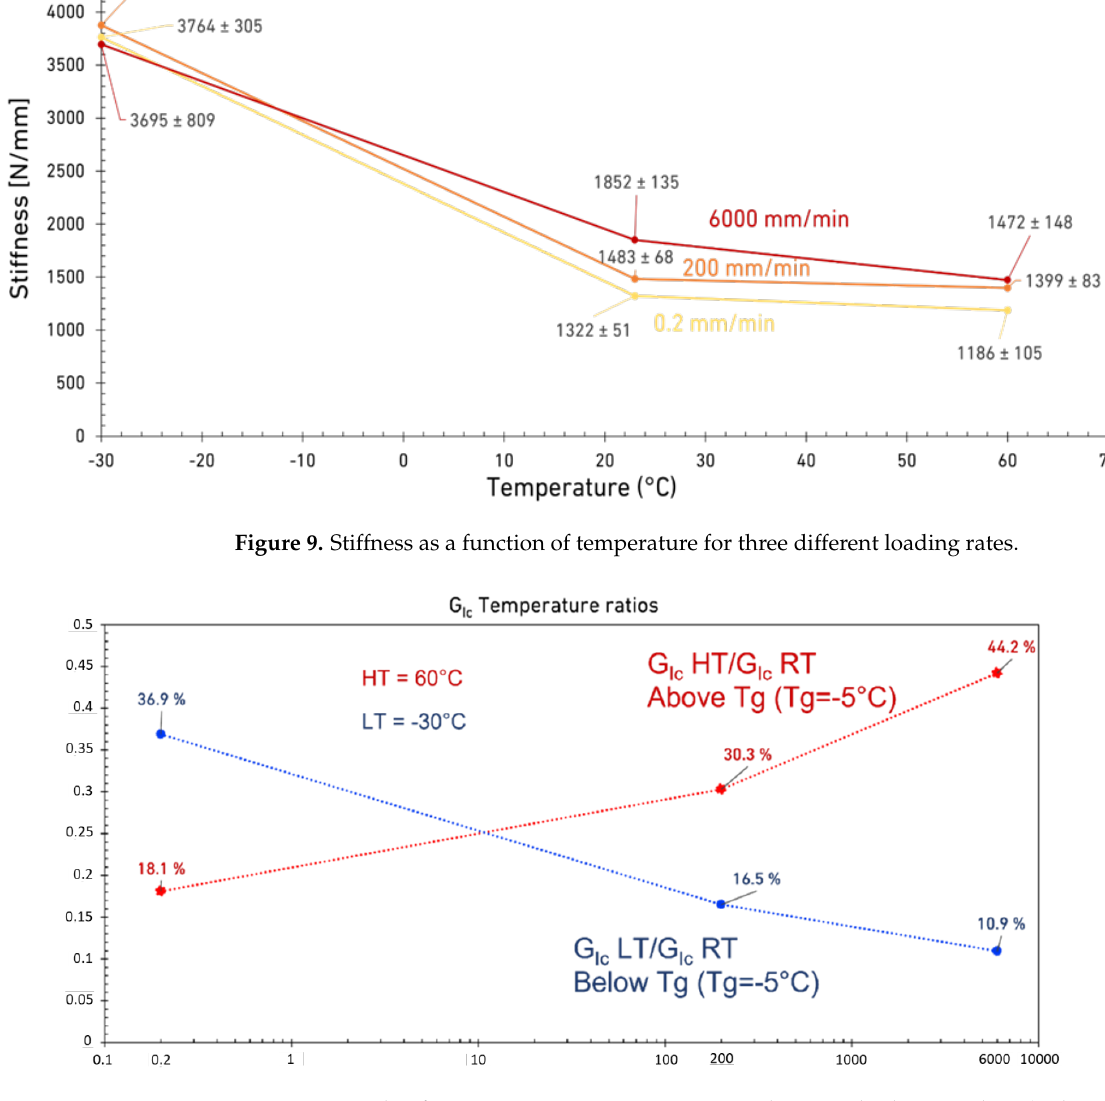
Figure 9. Stiffness as a function of temperature for three different loading rates.